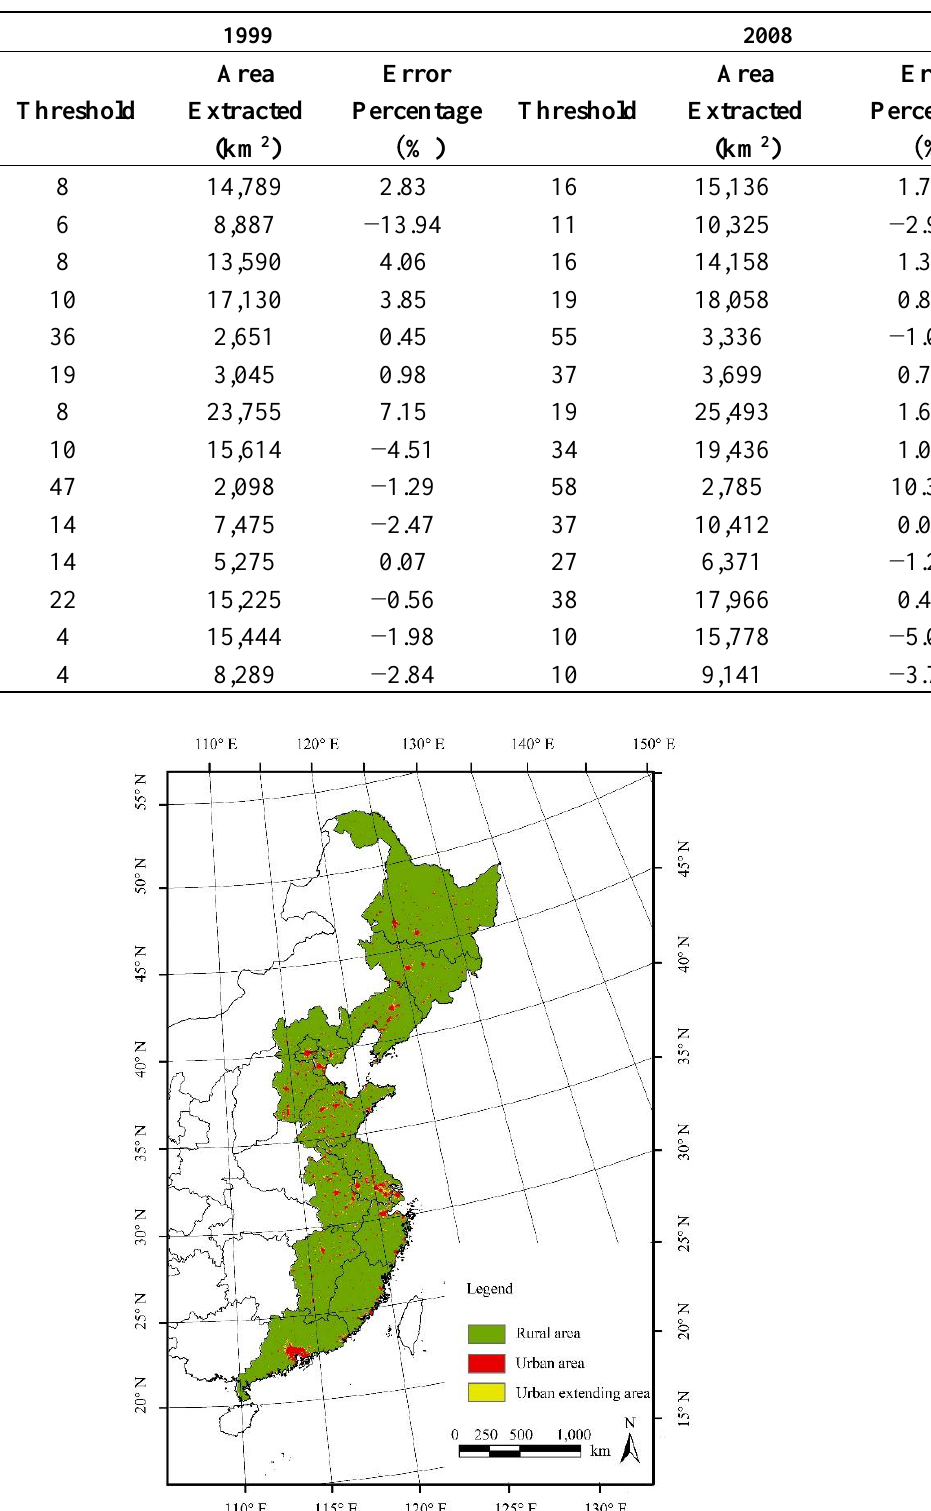
Table 1. Accuracy assessment of urban area extraction using DMSP/OLS in 1999 and 2008.